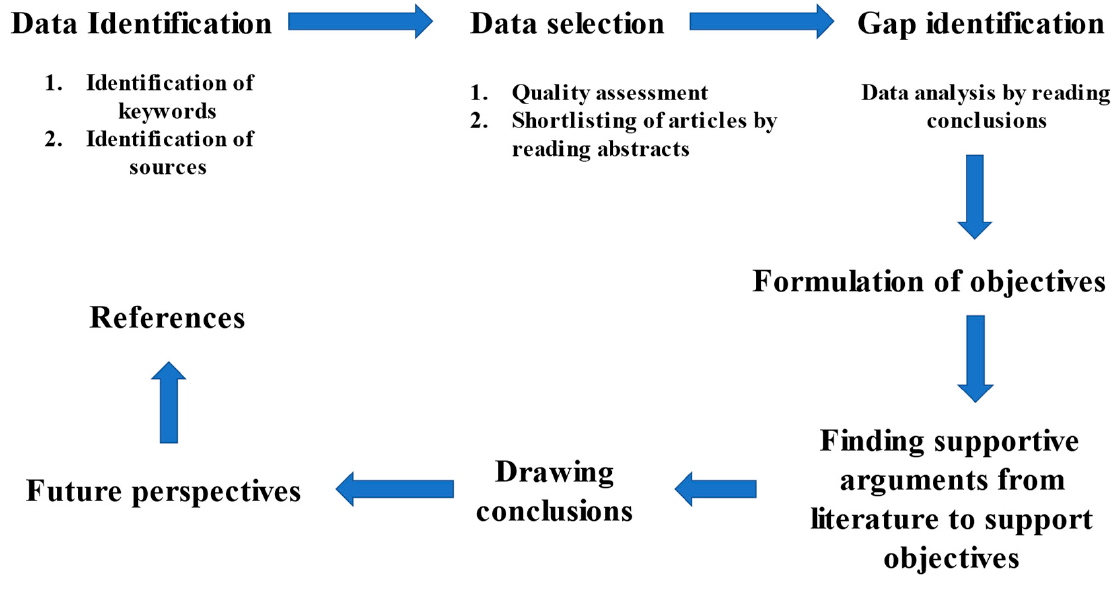
Figure 1. Review of methodology.